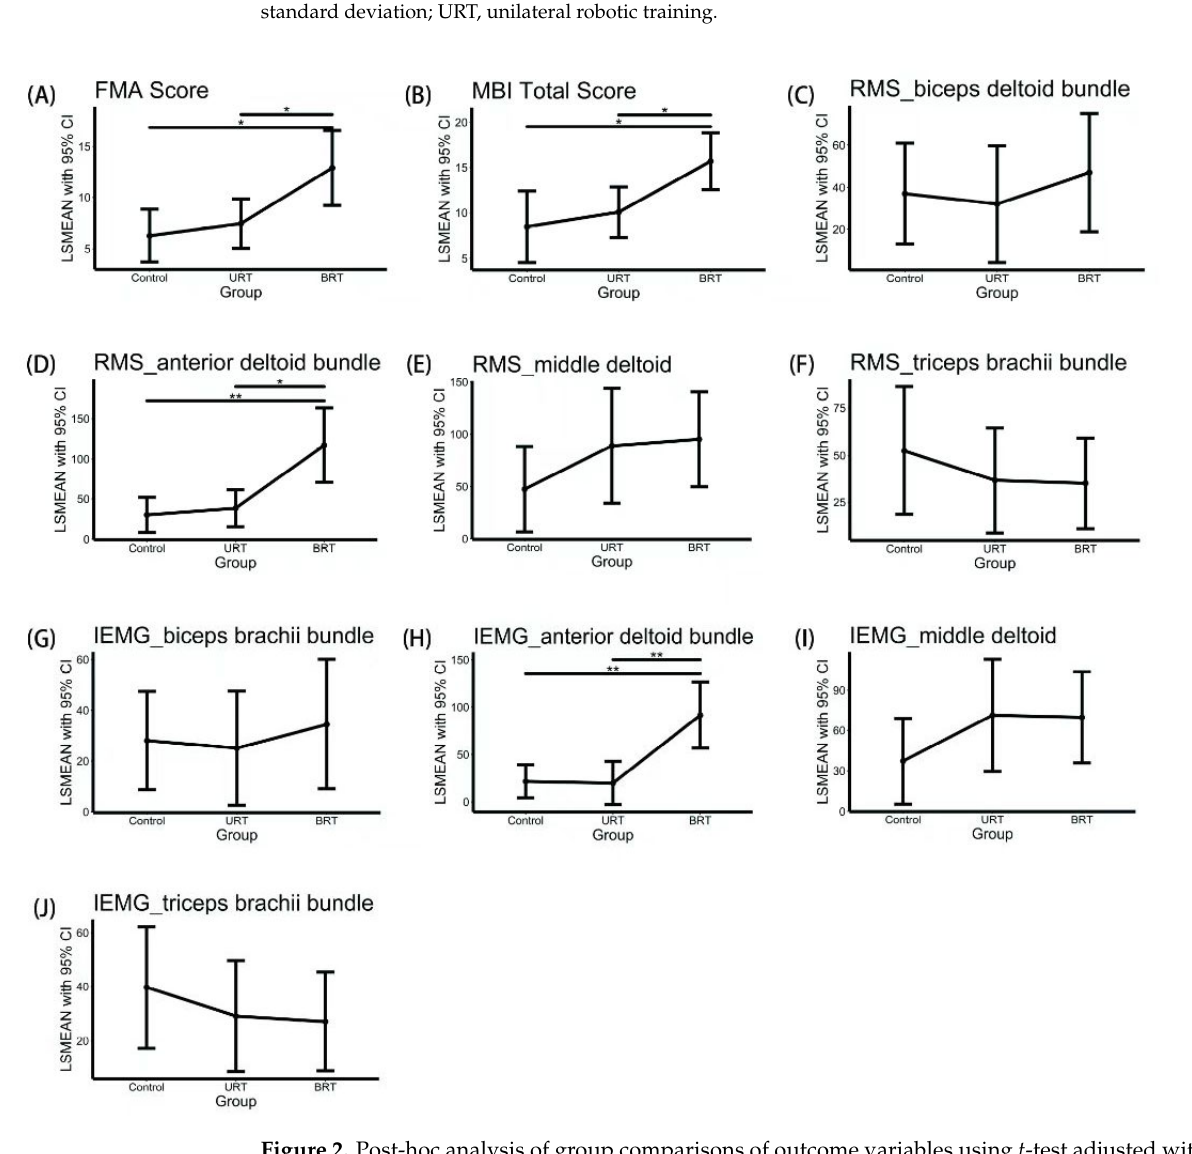
Figure 2. Post-hoc analysis of group comparisons of outcome variables using t -test adjusted with the Bonferroni method, p -values of post hoc tests were shown in Supplementary Table S3; * p < 0.0167, ** p < 0.0033. Post-hoc comparisons: ( A ) Fugl-Meyer Assessment–Upper Extremities (FMA-